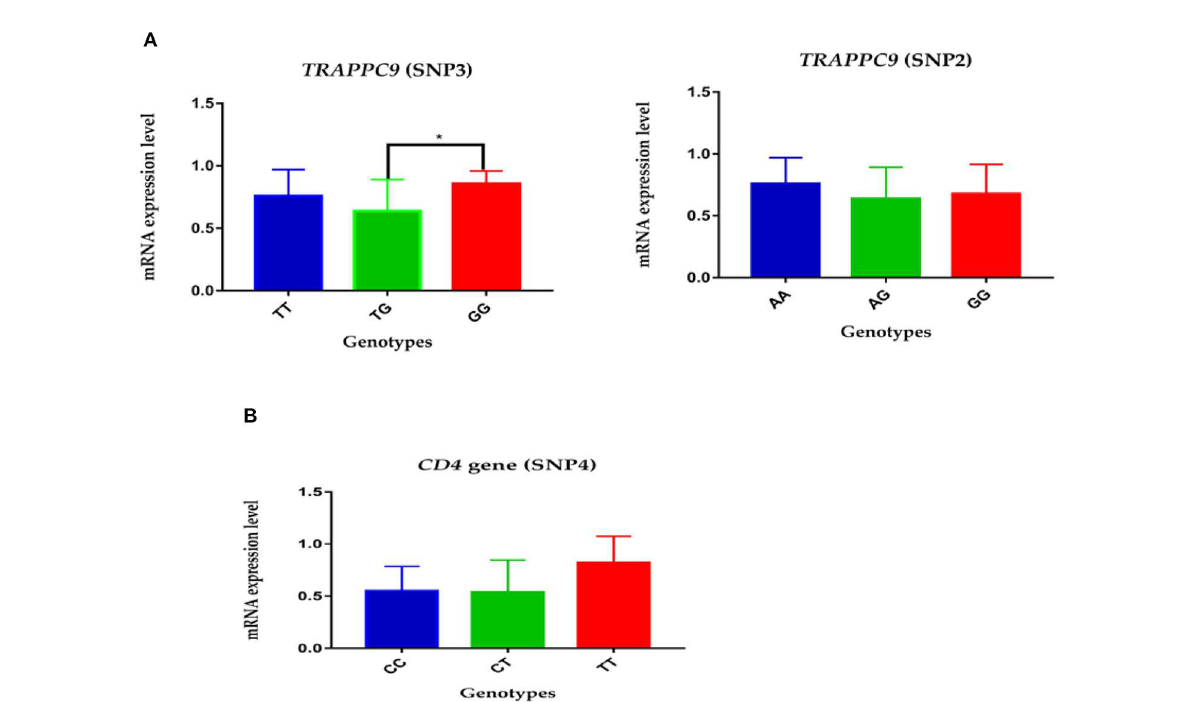
FIGURE1 The relative mRNA expression level of polymorphisms in TRAPPC9 and CD4 gene: (A) The expression level of genotypes in SNP2 and SNP3 of TRAPPC9: the GG genotype show significantly higher relative mRNA expression than TG in SNP3; however, no significant difference was reported among the three genotypes of SNP2. (B) The relative genotypes expression of SNP4 in CD4 gene: the TT genotype showed comparatively higher relative mRNA expression than CT and